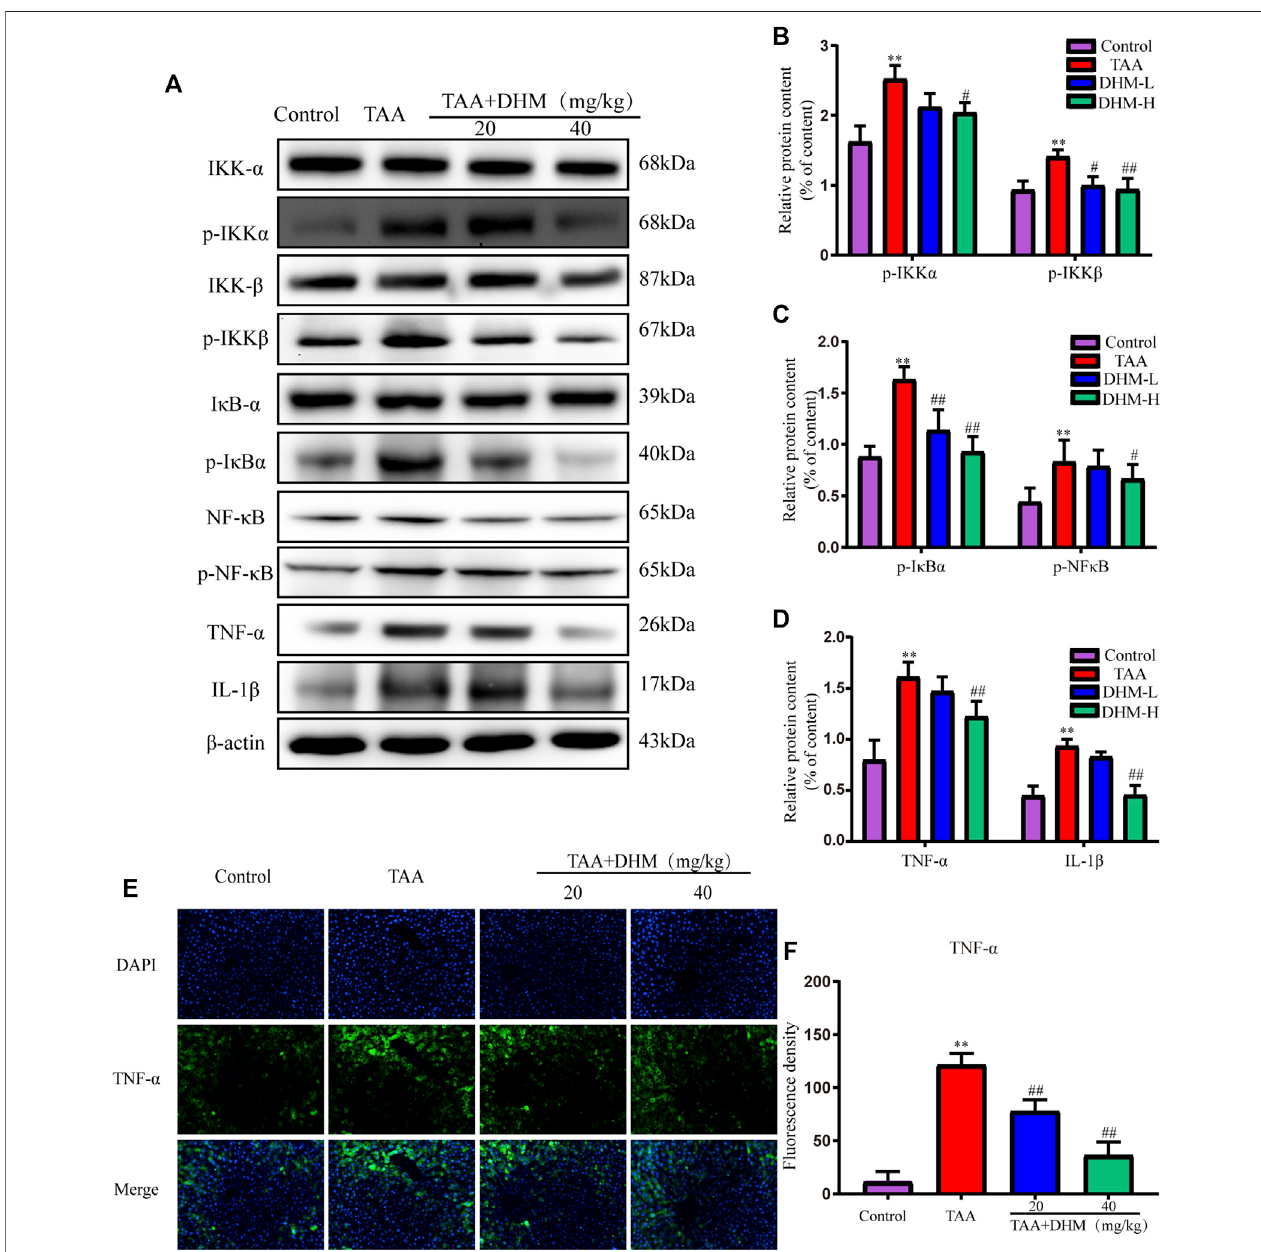
FIGURE 4 | DHM inhibits NF- κ B-mediated in fl ammatory in fi ltration to reverse TAA-induced liver fi brosis. The protein expression levels of p -IKK α , IKK α , IKK β , p- IKK β , I κ B α , p- I κ B α , NF κ B, p- NF κ B, TNF- α and IL-1 β in liver tissues were examined by western blot (A) , The protein expression levels of p -IKK α , IKK β (B) , The protein expression levels ofp- I κ B α , p-NF κ B (C) , Theprotein expression levels ofTNF- α and IL-1 β (D) , Theprotein expression levels ofTNF- α (E) and Fluorescence density (F) ; Column charts showed relative expression levels of target protein, and protein expression levels were performed by quanti fi cation of relative protein expression analysis in each group. Data was expressed as the mean ± SD. The differences between groups were analyzed by two tailed T-test or one-way analysis of variance (ANOVA). ** p < 0.01, * p < 0.05 versus control group; ## p < 0.01, # p < 0.05 versus TAA group.